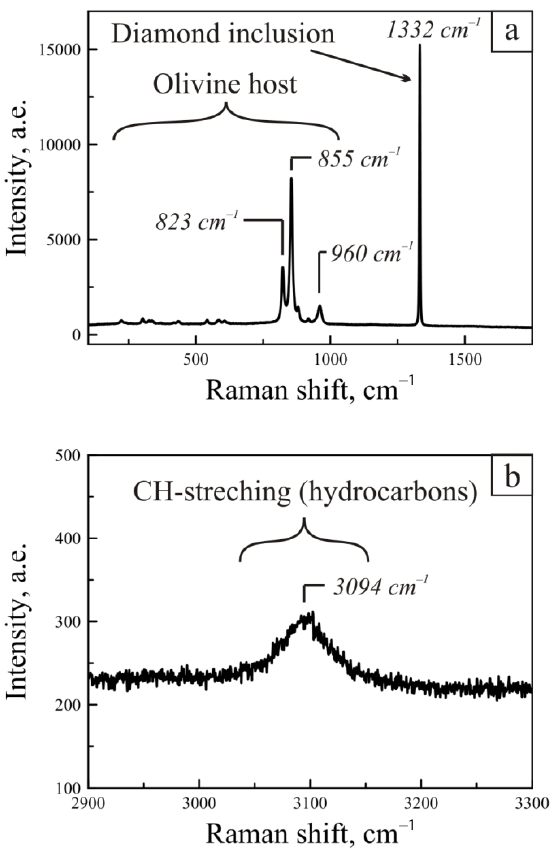
Figure 4. Raman spectra of studied sample: ( a ) spectrum of the forsterite matrix and the diamond inclusion; ( b ) the mode of aromatic or olefinic compounds on the diamond inclusion interface.